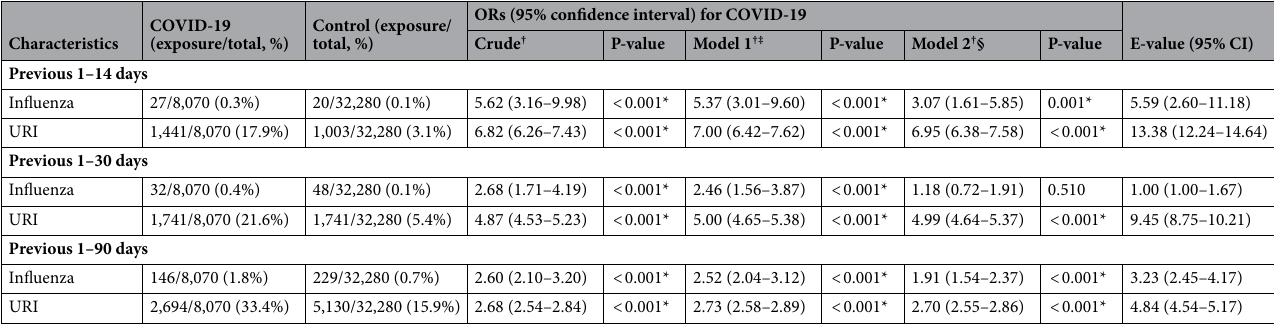
Table 2. Crude and adjusted odds ratios of influenza and URI (previous 1–14, 1–30, and 1–90 days) for COVID-19 infection in all participants. *Conditional logistic regression model, Significance at P < 0.05. † Stratified model for age, sex and income. ‡ Model 1 was adjusted for CCI scores, asthma, COPD, and hypertension. § Model 2 was adjusted for model 1 plus influenza and